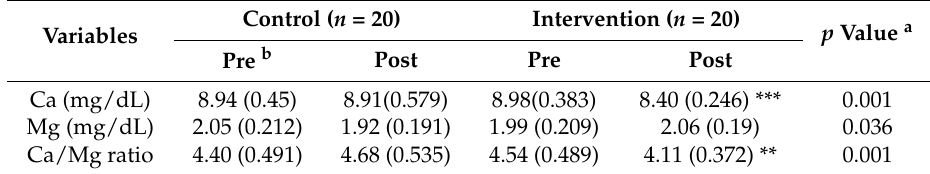
Table 3. Differences in the Ca, Mg, and Ca/Mg ratio between the